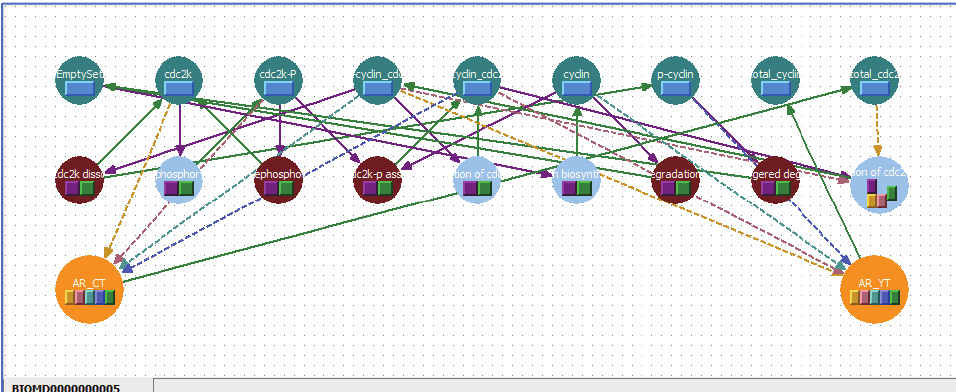
Figure 10. Screenshot immediately after importing a SBML model into WinBEST-KIT. The symbols are arranged according to certain rules because there are no coordinate data in SBML. For that reason, the visibility of the imported SBML models is inevitably